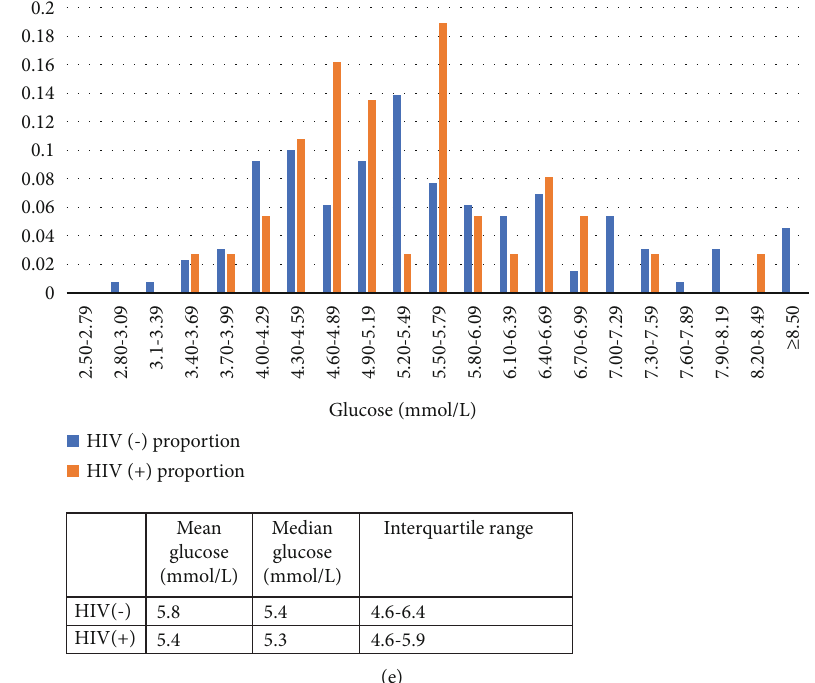
Figure 2: (a) Venous glucose values amongst those living with HIV vs. those without during initial visit prior to 18 weeks. (b) Venous HbA1c values amongst those living with HIV vs. those without during their 24-32-week visit. (c) Venous fasting glucose values amongst those living with HIV vs. those without during their 24-32-week visit. (d) Venous glucose values 60 minutes after 75g glucose load amongst those living with HIV vs. those without during their 24-32-week visit. (e) Venous glucose values 120 minutes after 75 g glucose load amongst those living with HIV vs. those without during their 24-32-week